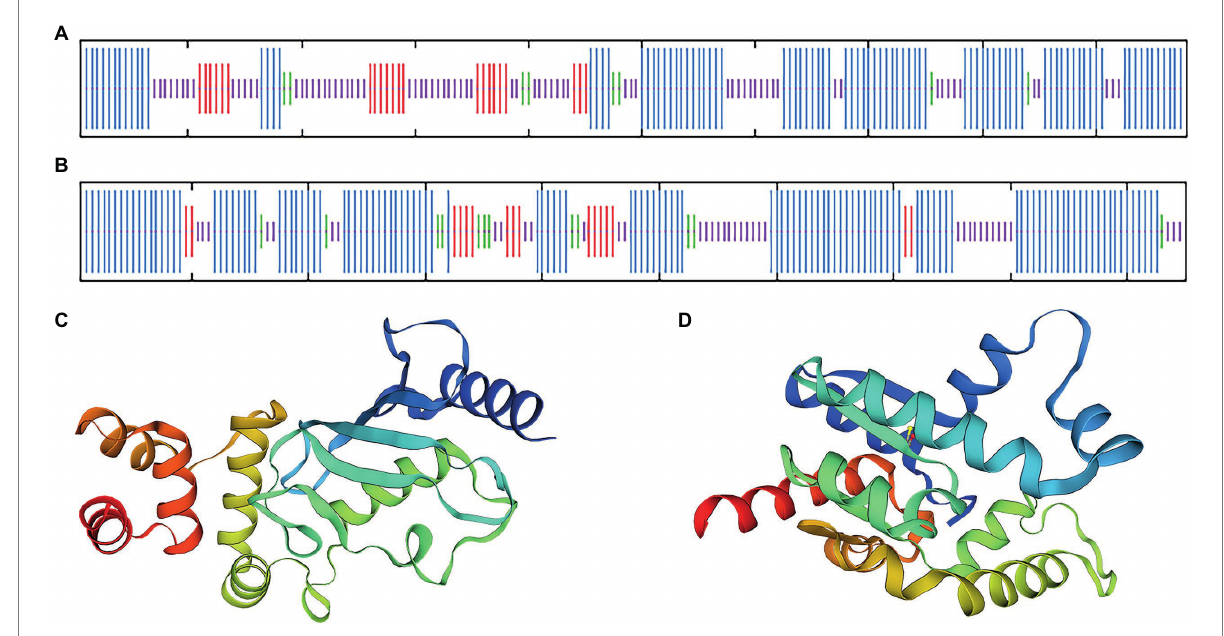
FIGURE 7 Transmembrane region, signal peptide, hydrophobicity, structure prediction of BDUbc and BDSKL1 . (A,B) Secondary structure prediction of BDUbc and BDSKL1, α -helix, random coil, extended strand, and β -turn are represented with blue, pink, red and green regions; (C,D) tertiary structure prediction of BDUbc and BDSKL1 .